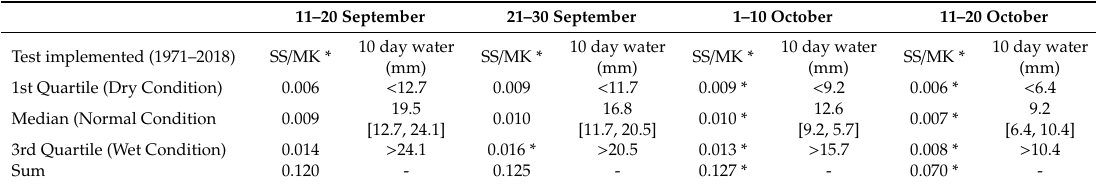
Table 2. Sen slope (SS) and total 10-day water discharges (see Section 3.3) in different conditions for 1971–2018. * indicates a significant trend obtained through the Mann-Kendall test.